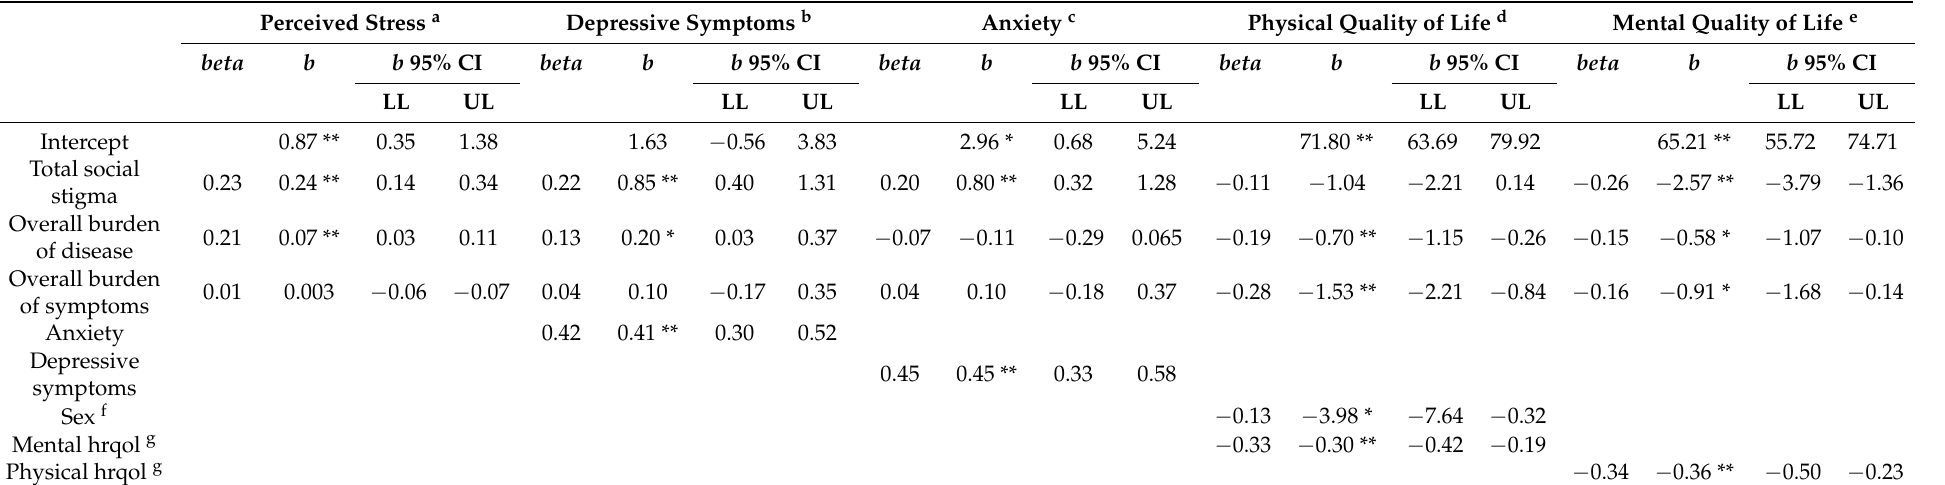
Table 3. Regression analyses with total social stigma as predictor and confounders to predict the various outcomes. Perceived Stress a Depressive Symptoms b Anxiety